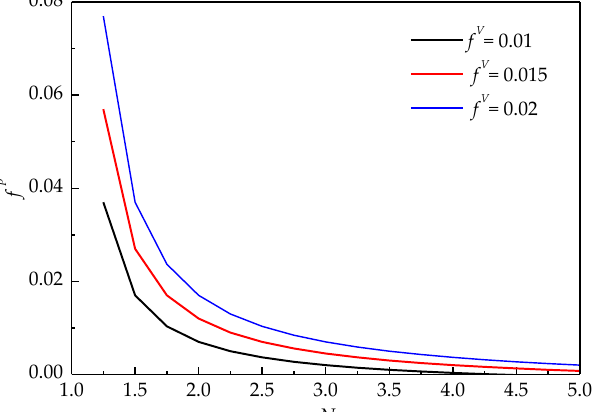
Figure 3 . The relationship between f P and N ( 𝑓 𝑙 = 0.003 ).